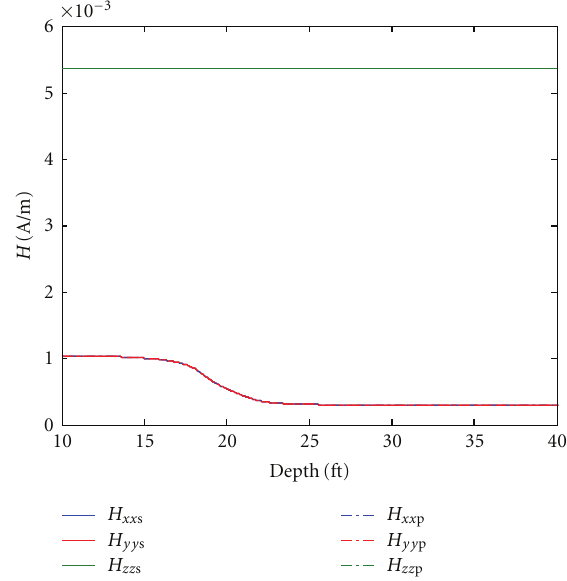
Figure 21: Comparison of H xx , H yy , and H zz (1000 points) from the serialized and parallelized